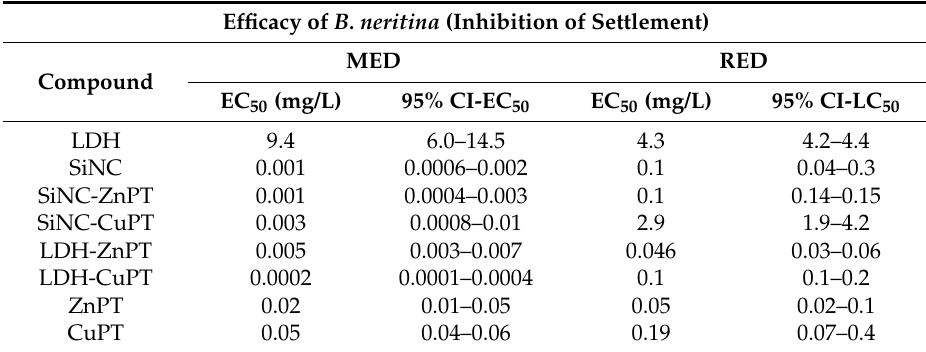
Table 3. EC 50 values for tested compounds on MED and RED